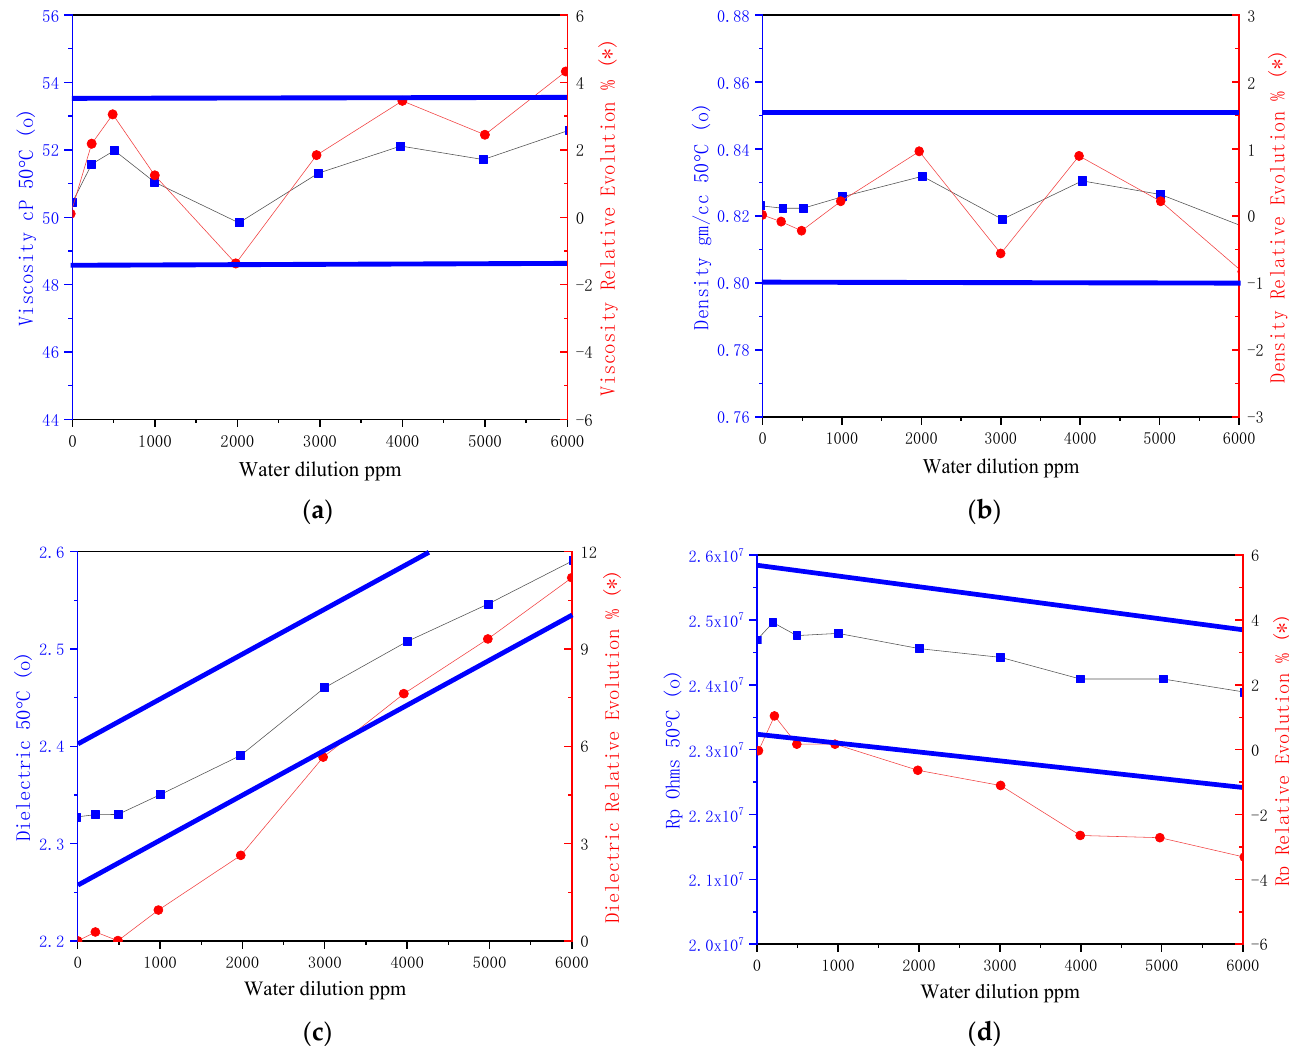
Figure 12. Water dilution in engine oil (15W40) at 50 °C: ( a ) viscosity; ( b ) density; ( c ) dielectric; and ( d ) Rp. Viscosity and density do not show any changes. The dielectric constant is linearly increased and the resistivity is linearly decreased with water dilution. These noticeable changes have been described in the literature and can be explained by the high dielectric constant of water ( ε =80) and the autoionization of water that can release free charge carriers, e.g., protons, into the oil.